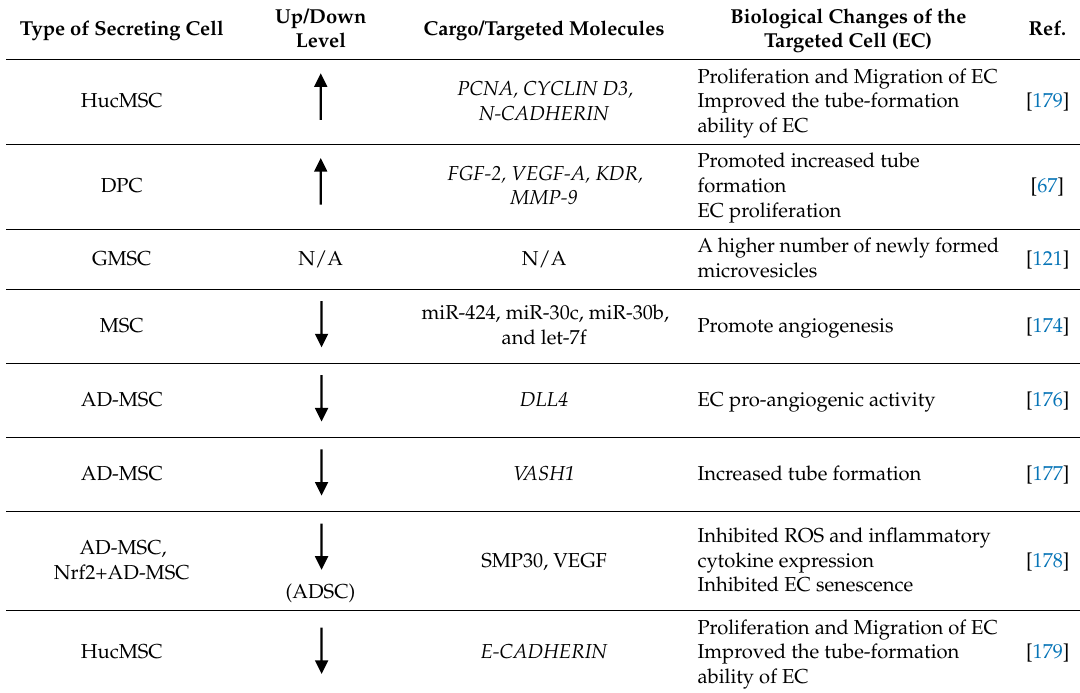
Table 2. Different types of pro-angiogenic exosome recreating cells, their cargo/targeted mRNAs, microRNAs or proteins, the resulted upregulation or downregulation and the biological changes made in the targeted cells (in this case the endothelial cells -ECs).